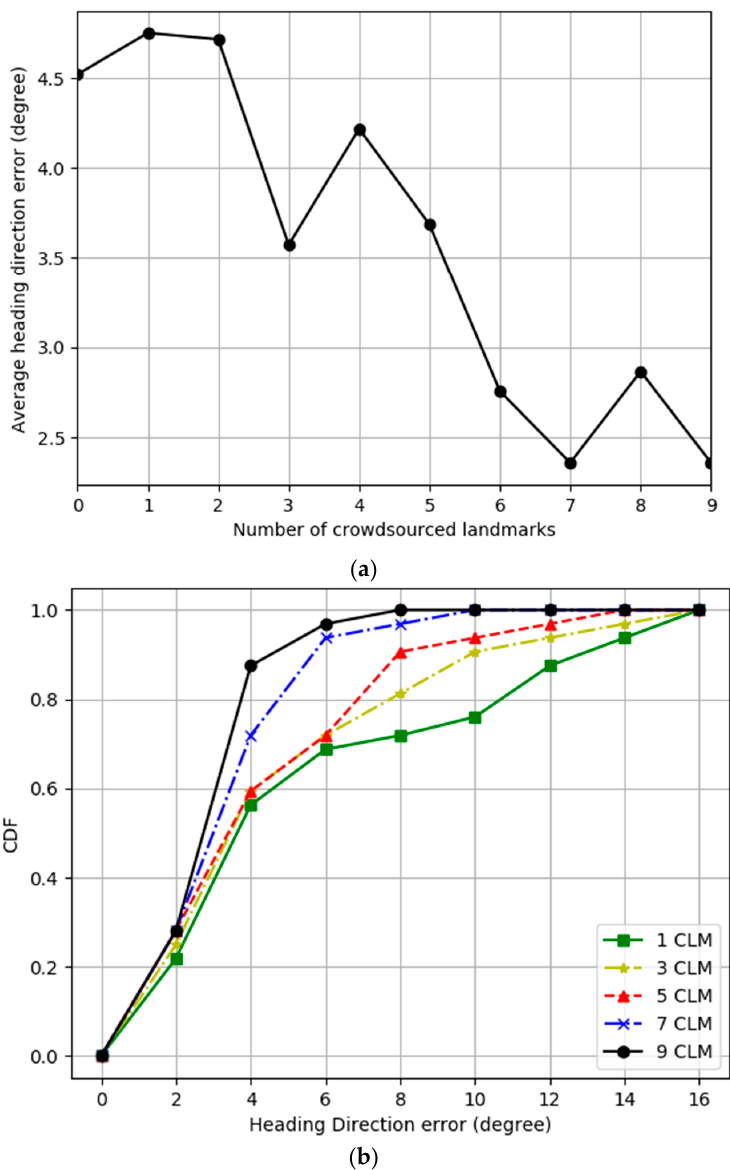
Figure 7. ( a ) Average heading direction error as a function of the number of crowdsourced landmarks ( b ) Cumulated heading direction error for the ground-truth reference heading direction for varying number of crowdsourced landmarks.